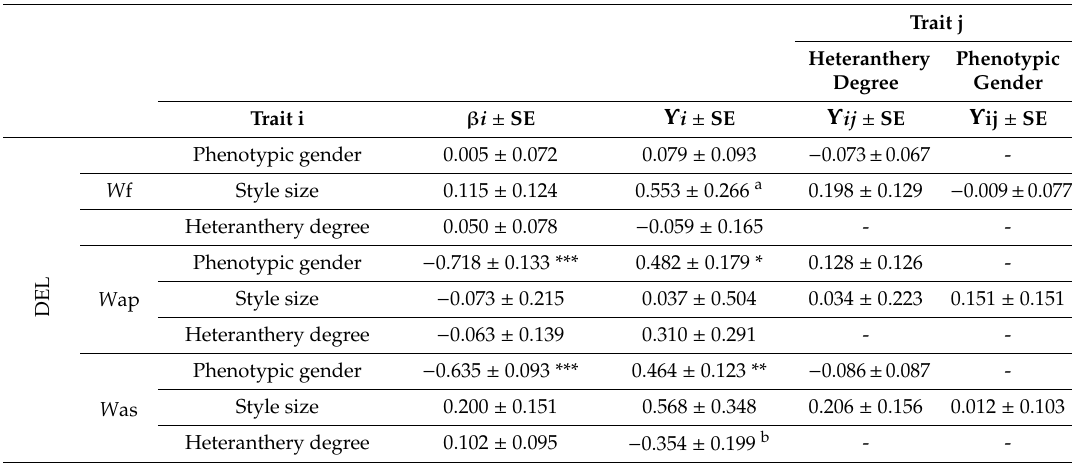
Table 2. Standardized selection gradients (directional, β i ; quadratic, γ ij and correlational, γ ij ) for floral traits and their correlation in Macairea radula through the female ( w f) and male ( w ap—antepetalous stamens—and w as—antesepalous stamens–) fitness components in the two studied populations.